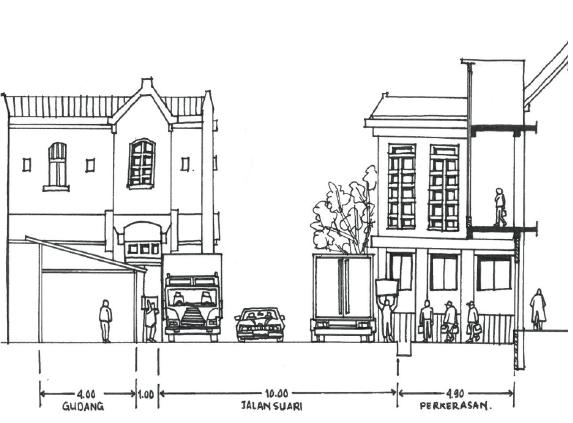
Fig. 10. The Building Façade of the Meaningful Place